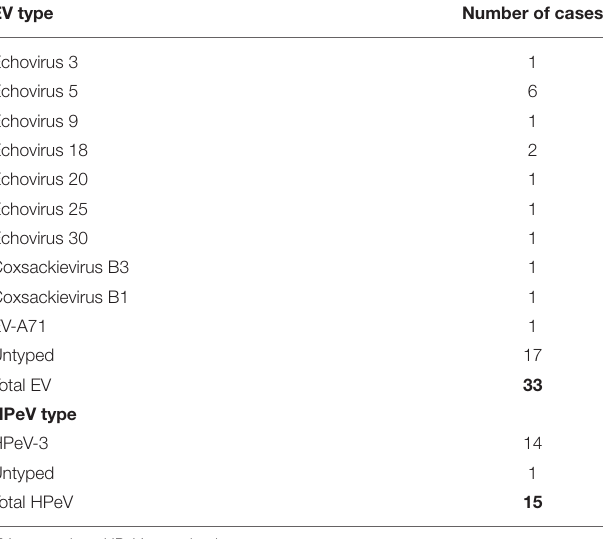
TABLE 1 | Clinical and laboratory findings of infants with EV and HPeV infections included in this study.